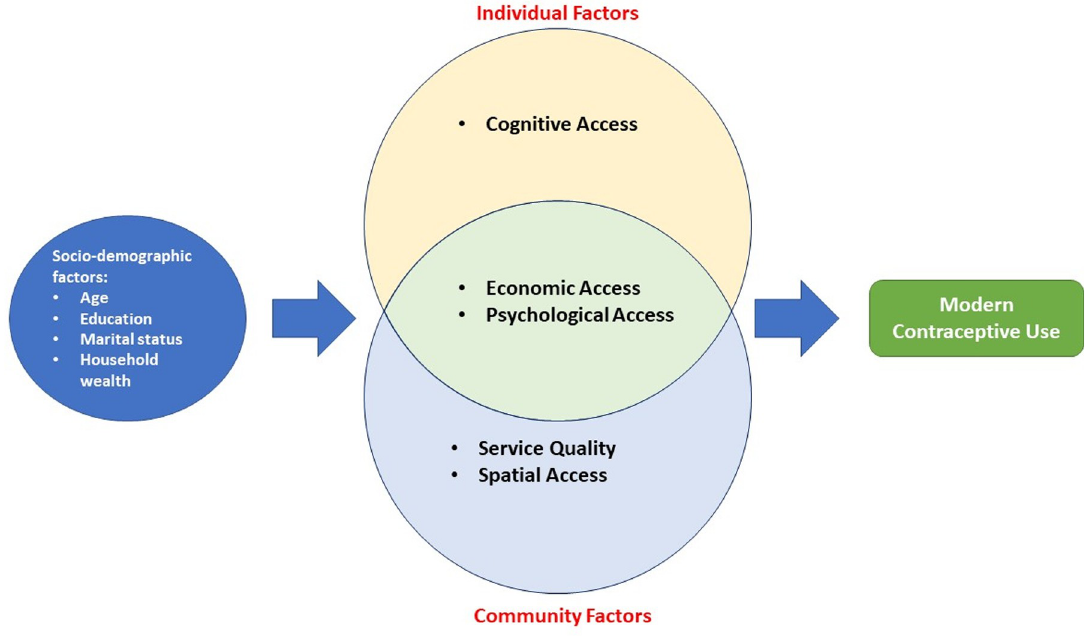
Fig 1. The conceptual framework of access to modern